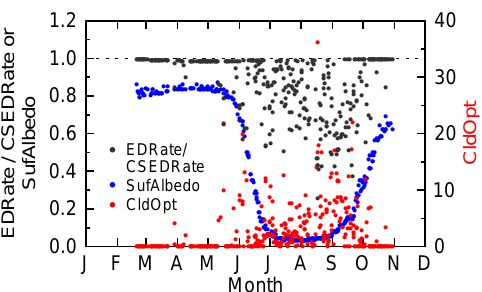
Figure 11. Comparison of ratio EDRate / CSEDRate (grey, left axis), SufAlbedo (blue, left axis) and CldOpt (red, right axis). All data are from the OMI data file for Barrow and the year 2007. The ratio EDRate / CSEDRate is equivalent to the cloud modification factor (CMF) at 360nm.